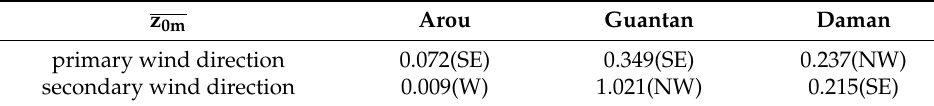
Table 5. Statistical table of averaged z 0m under prevailing wind direction.